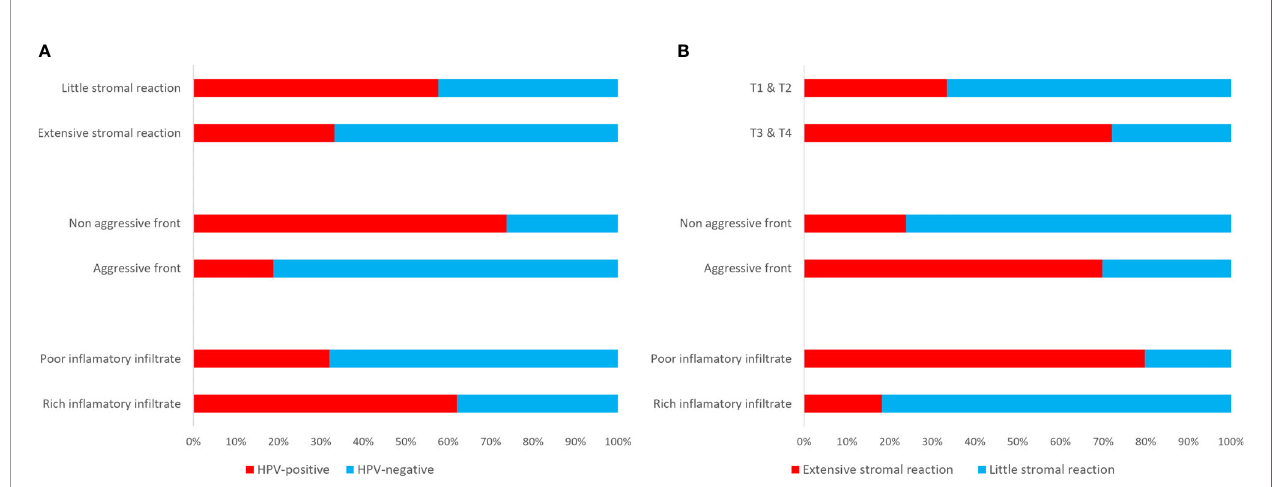
FIGURE 1 | Clinico-pathological correlations depicting an extensive (scores 3&4) stromal reaction, an aggressive (scores 3&4) invasive front and a poor (scores 3&4) in fl ammatory in fi ltrate in HPV-negative HNSCC as compared to the HPV-positive cases (A) , and associations between extensive stromal reaction and bigger size tumours, an aggressive invasive front, and a poor in fl ammatory in fi ltrate (B)